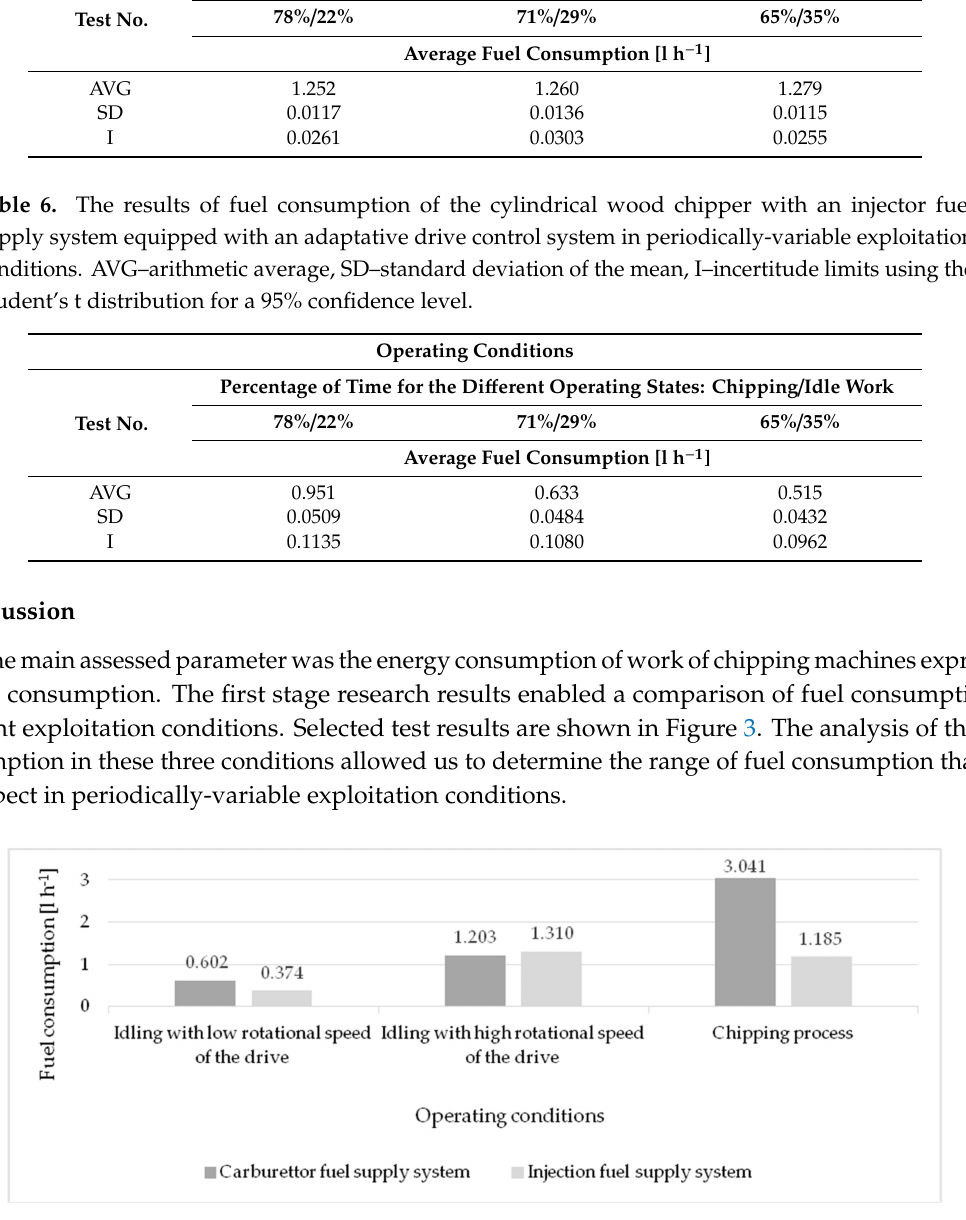
Figure 3. Fuel consumption in selected operating conditions: Idle work with high (1) and low (2) rotational speed, with a continuous chipping process